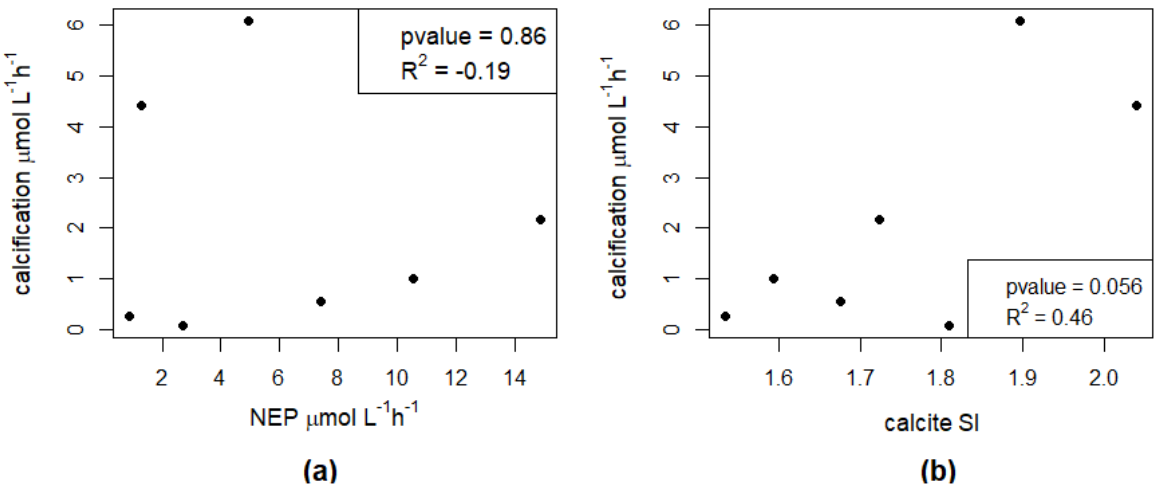
Figure 2. ( a ) Relationship between net ecosystem production (NEP) and calcification rates. ( b ) Relationship between calcite SI and calcification rates.